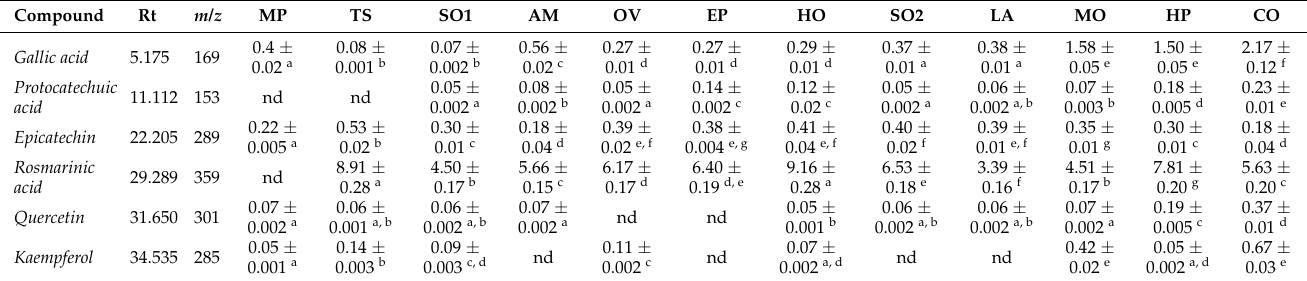
Figure 7. The TFC compared for the 3 extraction methods ( a ) CS; ( b ) FG. According to the t -test, the different lower-case letters (a–c) represent the significant differences ( p < 0.05) between samples from the same plant obtained by different extraction methods. Table 4. Individual polyphenols (mg/g) detected using